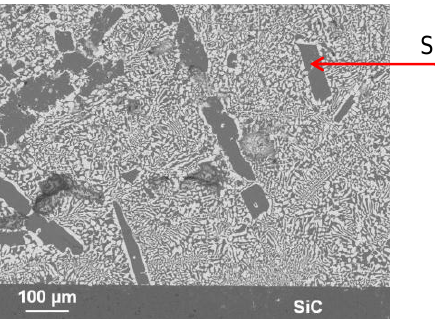
Figure 17. Cross-section of a Si-Pr alloy on sintered α-SiC obtained after 15 min at Fig. 17 – Cross-section of an Si-Pr alloy on sintered  -SiC obtained after 1250 °C in high vacuum. The primary Si crystals are surrounded by the eutectic PrSi 2 -Si. 15 min at 1250°C in high vacuum. The primary Si crystals are surrounded by the eutectic PrSi -Si. The reactivity is negligible and the The reactivity is negligible and the interface is mechanically strong [39]. 2 interface is mechanically strong [39].